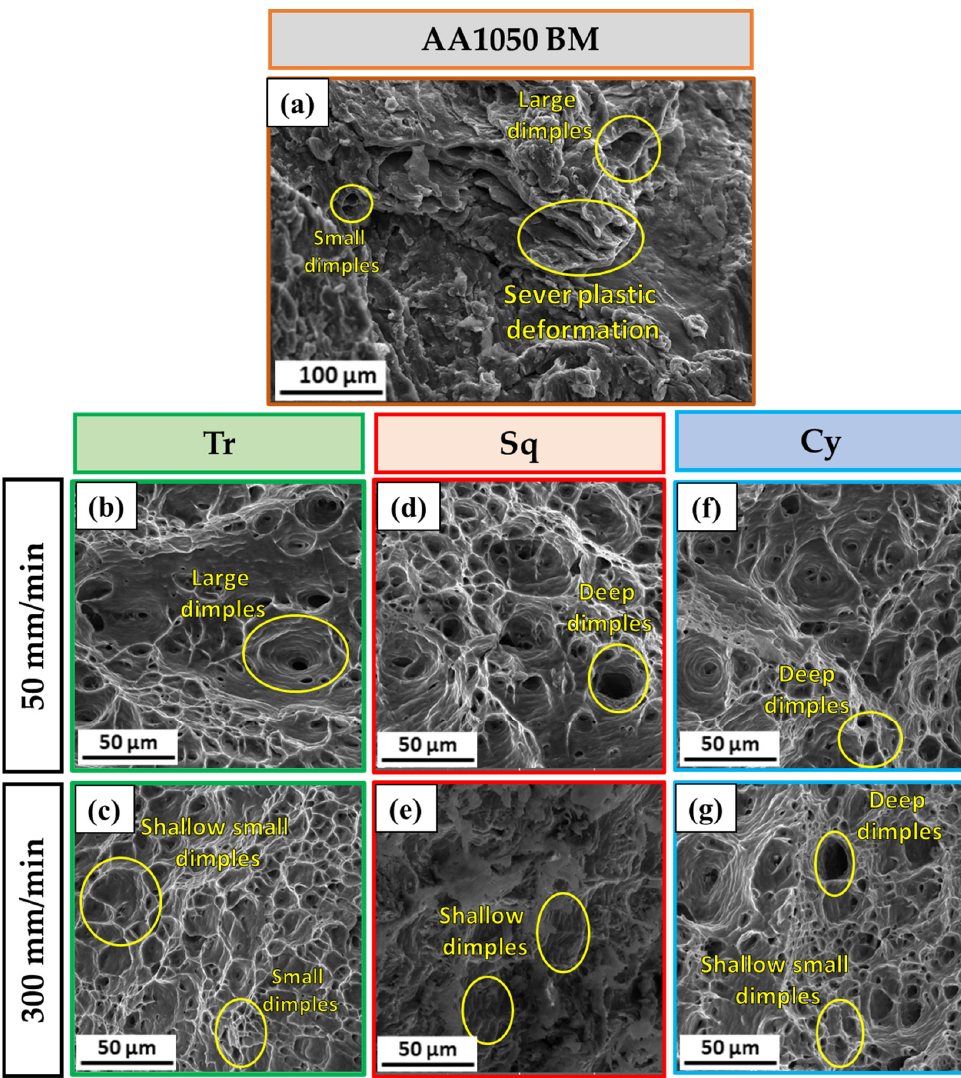
Figure 5. SEM images of the fracture surfaces of the failed specimens after the tensile test for ( a ) AA1050 BM and ( b – f ) and ( c – g ) for the processed materials using the three-pin geometries at the BT-FSP variables of TS of 50 mm/min and 300 mm/min, respectively.